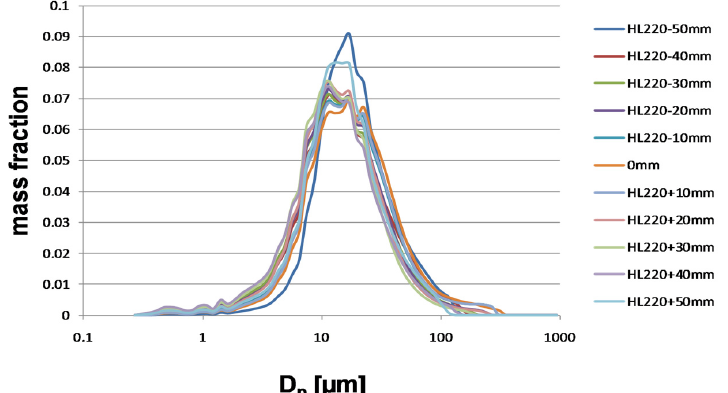
Figure 2. Setup of droplet size measurement.